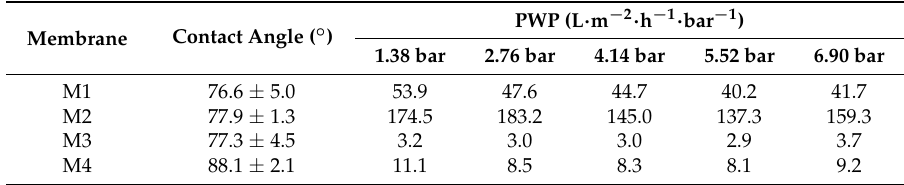
Table 2. The pure water permeability/unit length (PWP) results for M1, M2, M3, and M4 using deionized water at varying TMP.